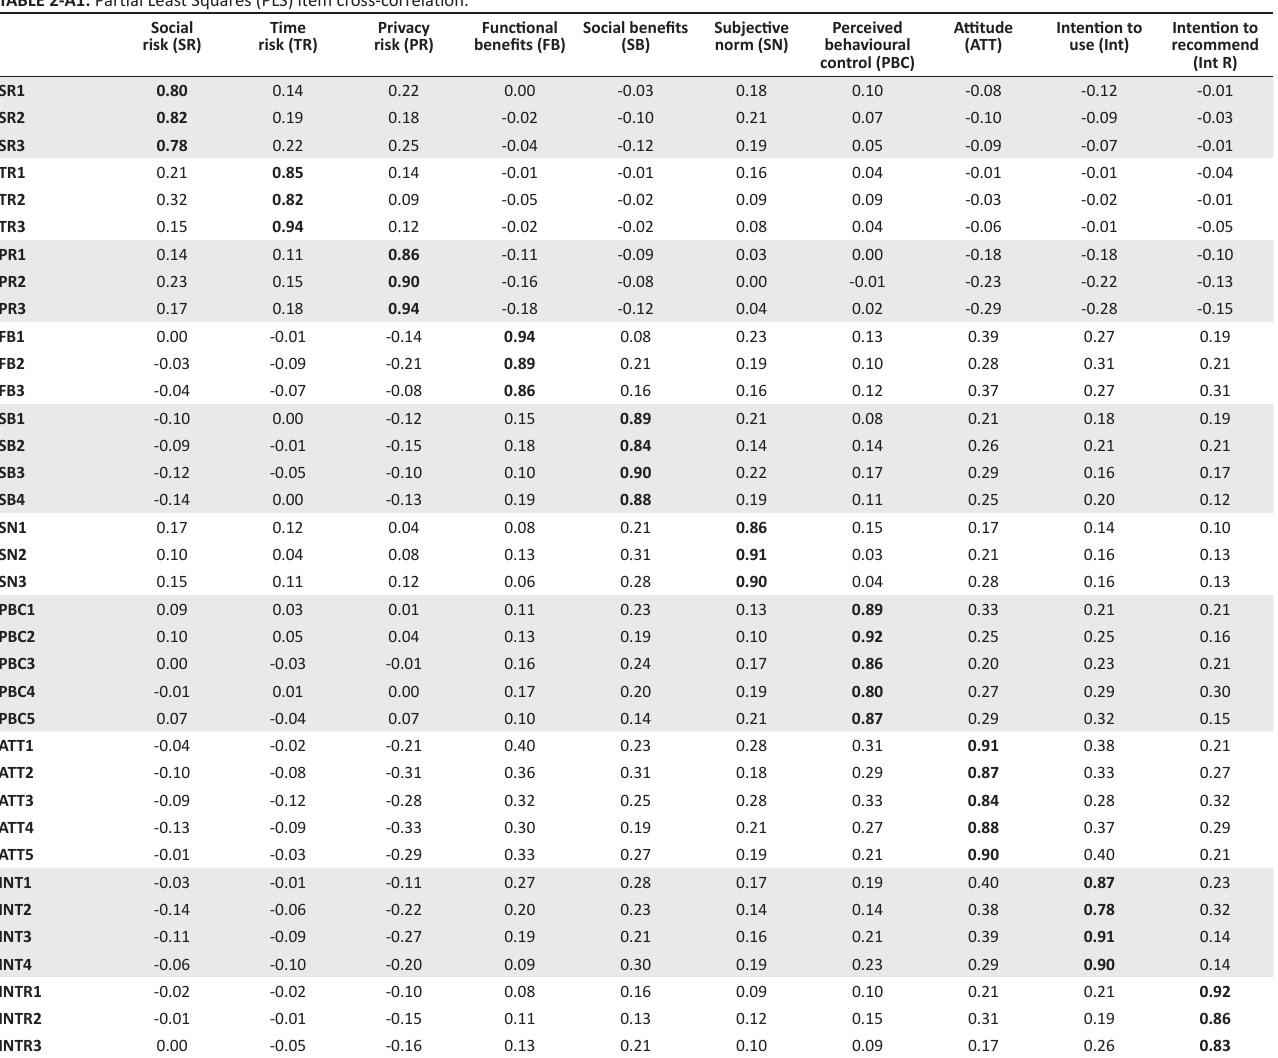
TABLE 2-A1: Partial Least Squares (PLS) item